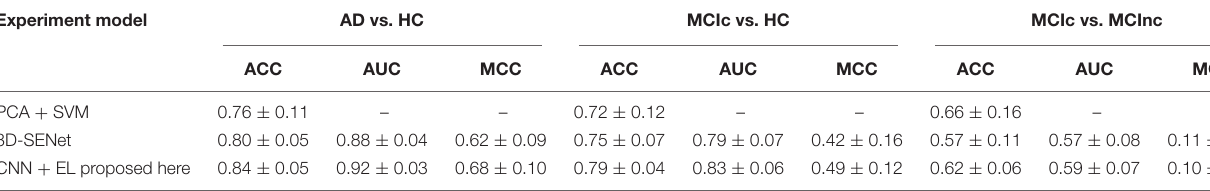
TABLE 5 | Comparison of experimental results with PCA + SVM (Christian et al., 2015) and 3D-SENet. Experiment model